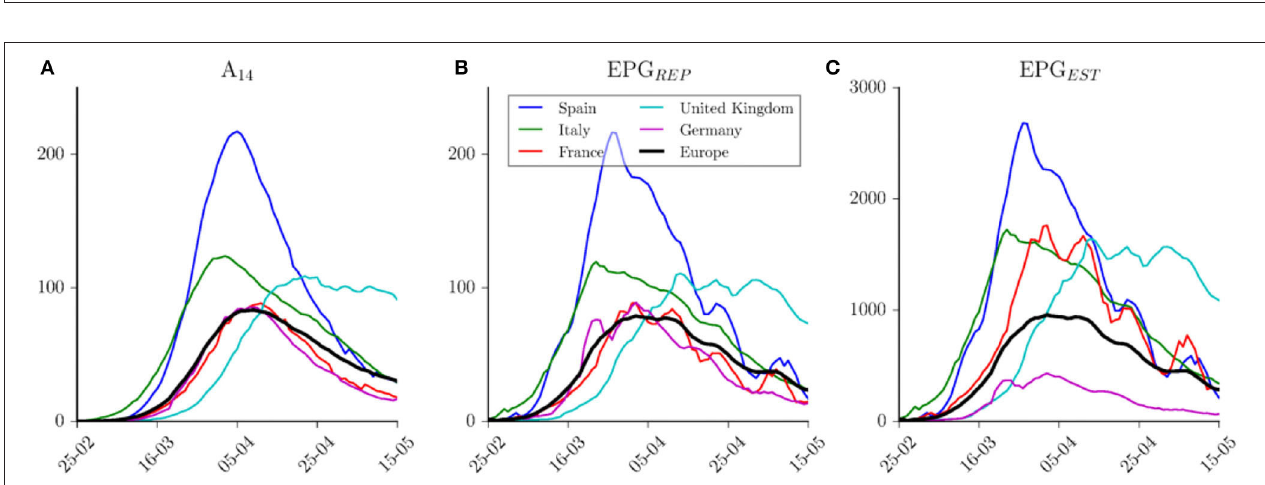
FIGURE 2 | Table with last indexes and reported cases value as of May 22, 2020. Left to right columns are: country, cumulative reported cases, number of total cases per 10 5 inhabitants (attack rate), cumulative number of reported deaths, number deaths per 10 5 inhabitants, reported number of new cases last 14 days (active cases), reported active cases per 10 5 inhabitants (14-day attack rate), estimated number of new cases for the last 14 days (active cases), estimated active cases per 10 5 inhabitants (14-day attack rate), 7-day moving average empiric reproduction number ( ρ 7 ), effective potential growth of reported cases (EPG REP ), estimated effective potential growth (EPG EST ), and Biocom-Cov degree. Each column has its own color scale as seen at the bottom of the figure. Data were obtained from the European Center for Disease Prevention and Control ( 24) and World Health Organization (25) on May 23, 2020.